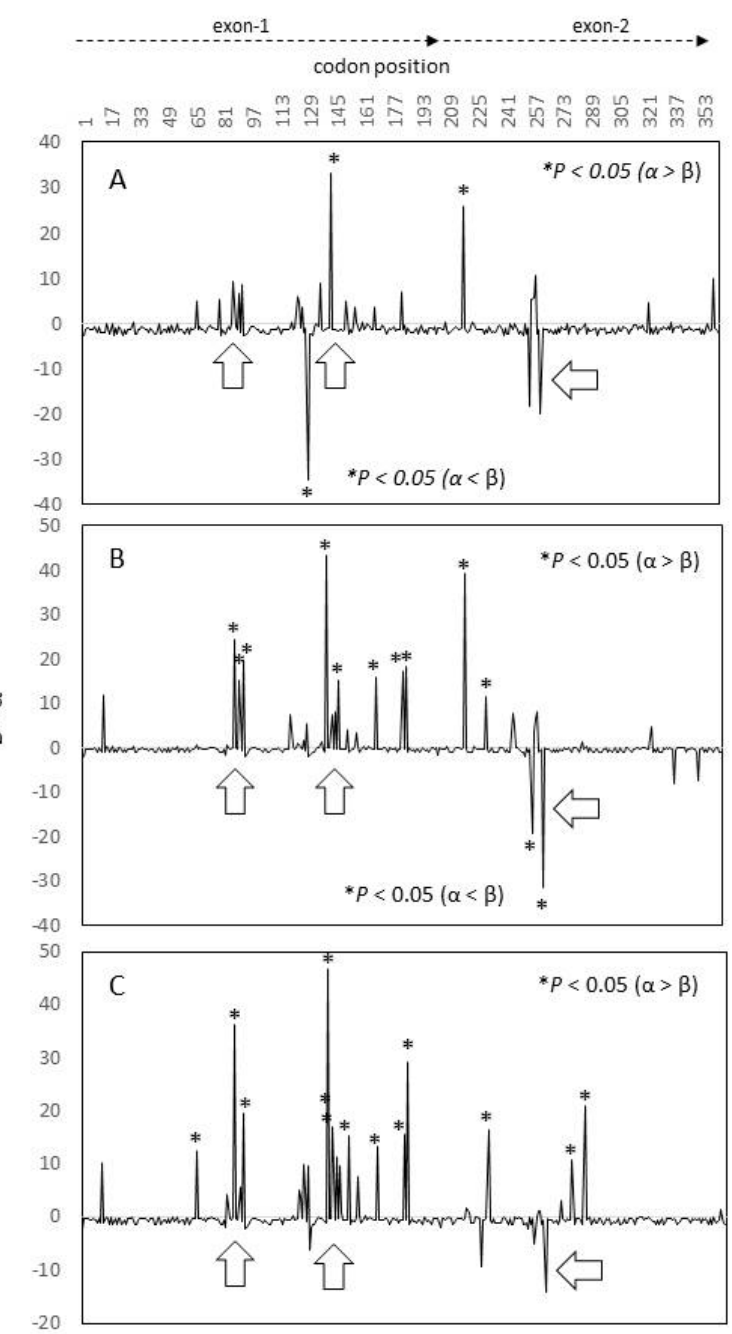
Figure 3. P. vivax cyrpa showing codons under selection in parasites from Southern Mexico ( A ), South America ( B ) and Asia ( C ). Codons with values of β - α above or below zero and significant (*) are suggested to be under positive or negative selection, respectively. FUBAR (https://www.datamonkey.org/). Arrows indicate positions under similar selective pressure for all parasites groups.